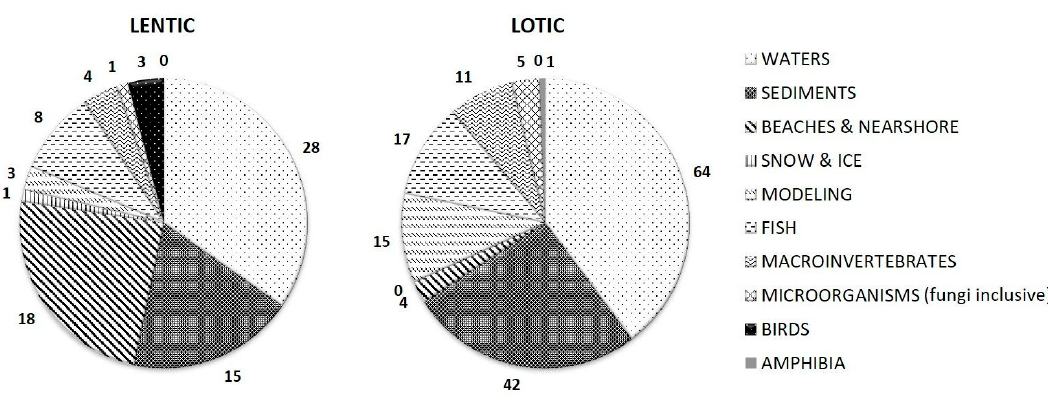
Figure 4. Topics examined on freshwater microplastics (fMPs): the number of studies in freshwater that analyse the different categories is reported.